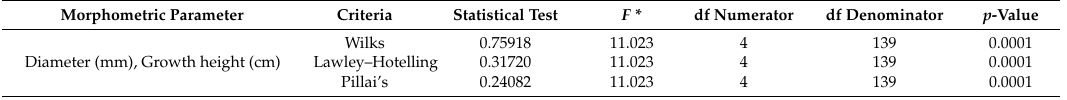
Table 6. Multiple variance analysis (MANOVA), with one-factor and two levels (control and treated) for the morphometric behavior of seedlings of R . mangle grown in treated artificial wetland habitats with urban residual wastes and control (only with sea water) ( p < 0.05).